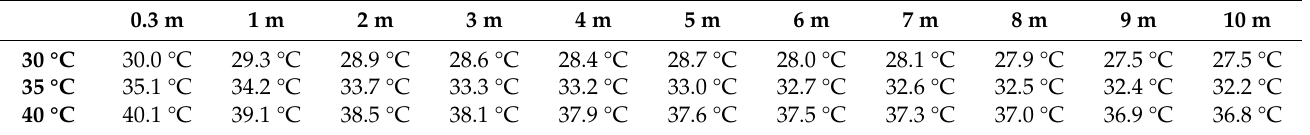
Table 4. The temperature estimation result from mapping function at a close distance (before correction).